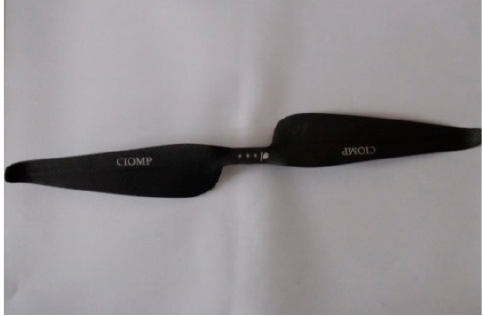
Figure 2. Manufactured